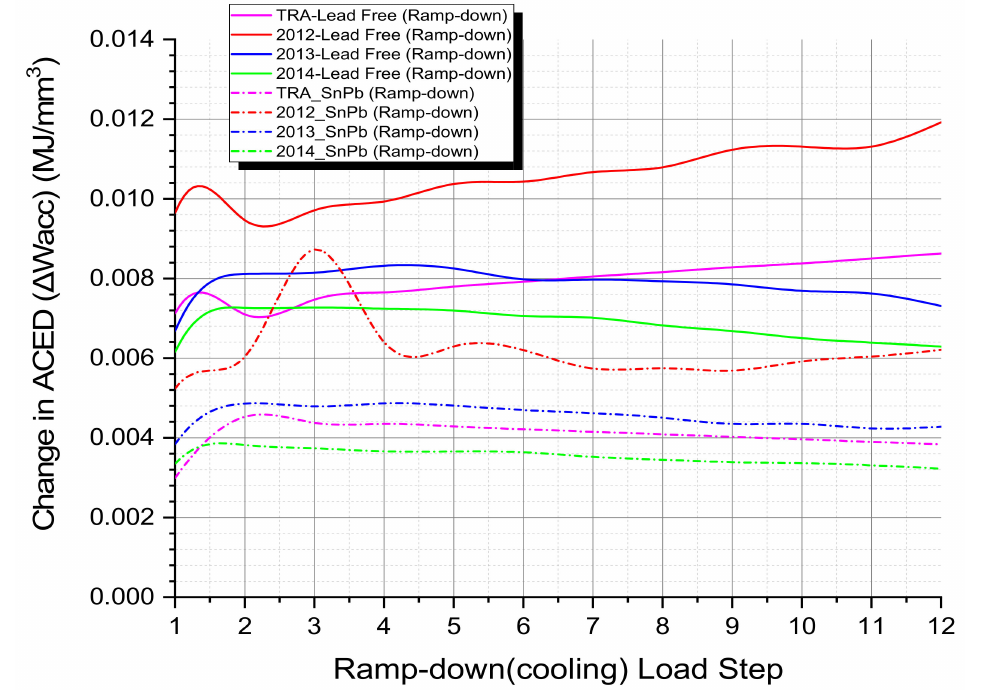
Figure 13. ACED damage accumulation from ramp-up load